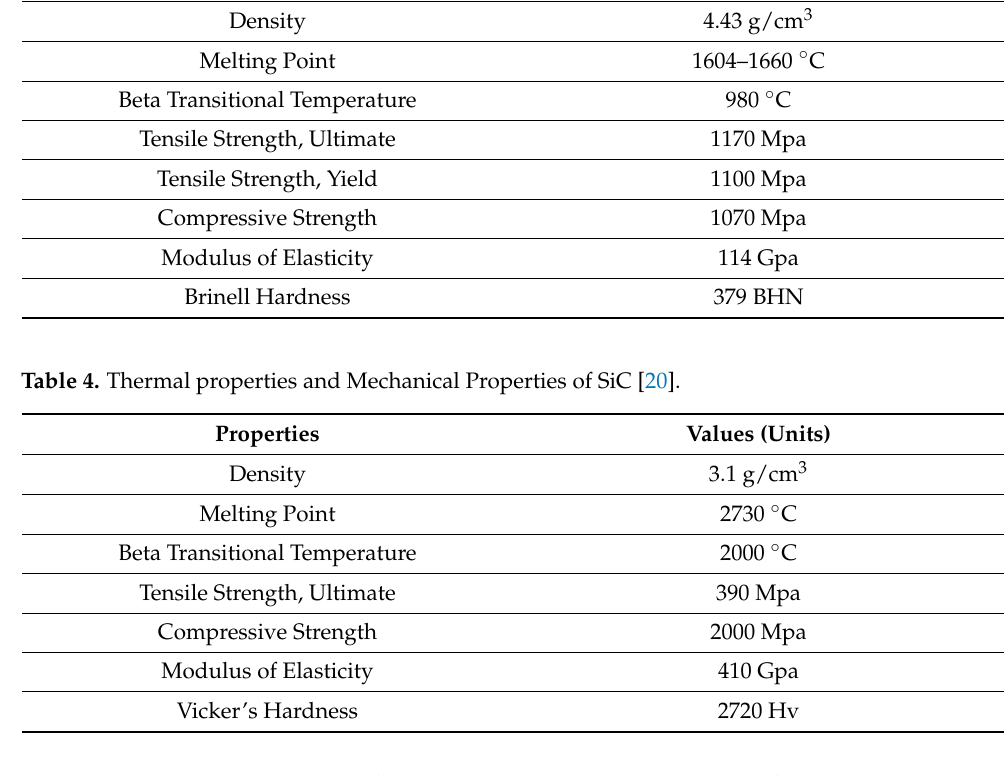
Table 4. Thermal properties and Mechanical Properties of SiC [20].